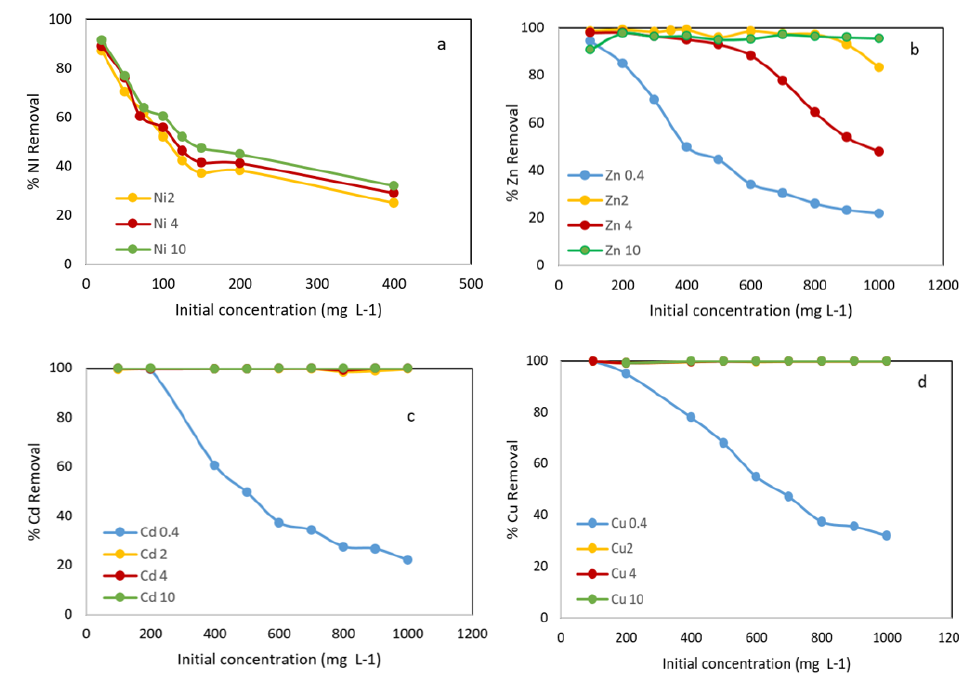
Figure 6. Metals removal onto WS versus initial concentration at different adsorbent concentration: 0.4 g L − 1 , 2 g L − 1 , 4 g L − 1 and 10 g L − 1 . ( a ) % Ni removal; ( b ) % Zn removal; ( c ) % Cd removal; ( d ) %